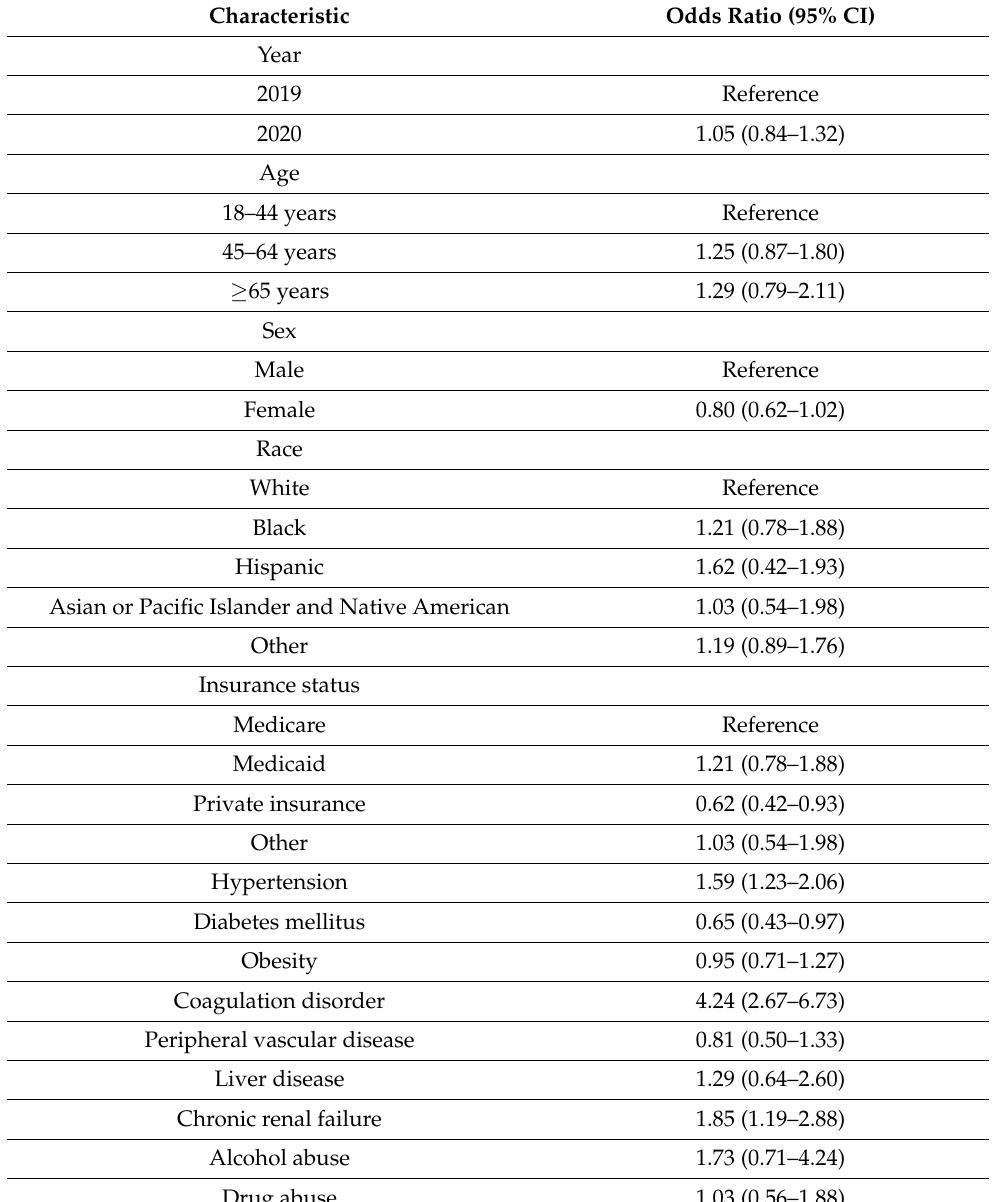
Table 4. Factors associated with prolonged length of